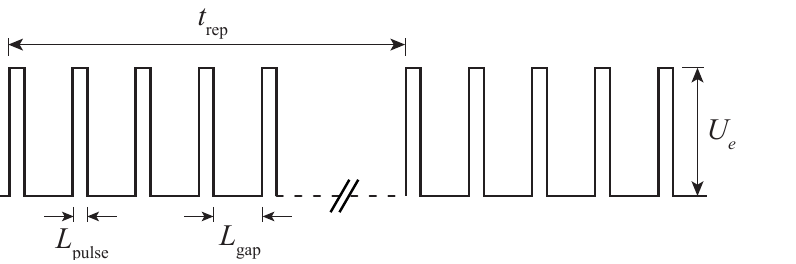
Figure 2. Illustration of gpDC generated with the NEPTUN system. The pattern is defined by the pulse length L pulse (s), gap length L gap (s), repetition time t rep (s) and applied voltage U e